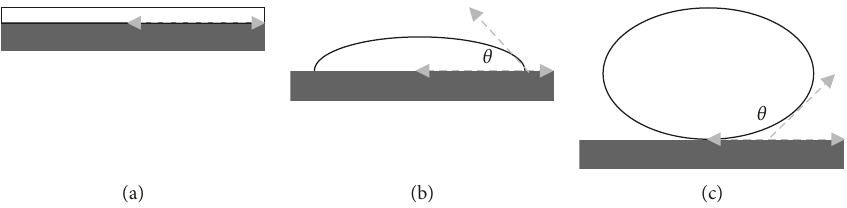
Figure 1: Wetting properties of liquid with different contact angles on solid surface. Source: adapted from Yuan and Lee [30]. (a) θ surface tension. (b) θ 90 ° lower surface tension substrate. (c) θ <